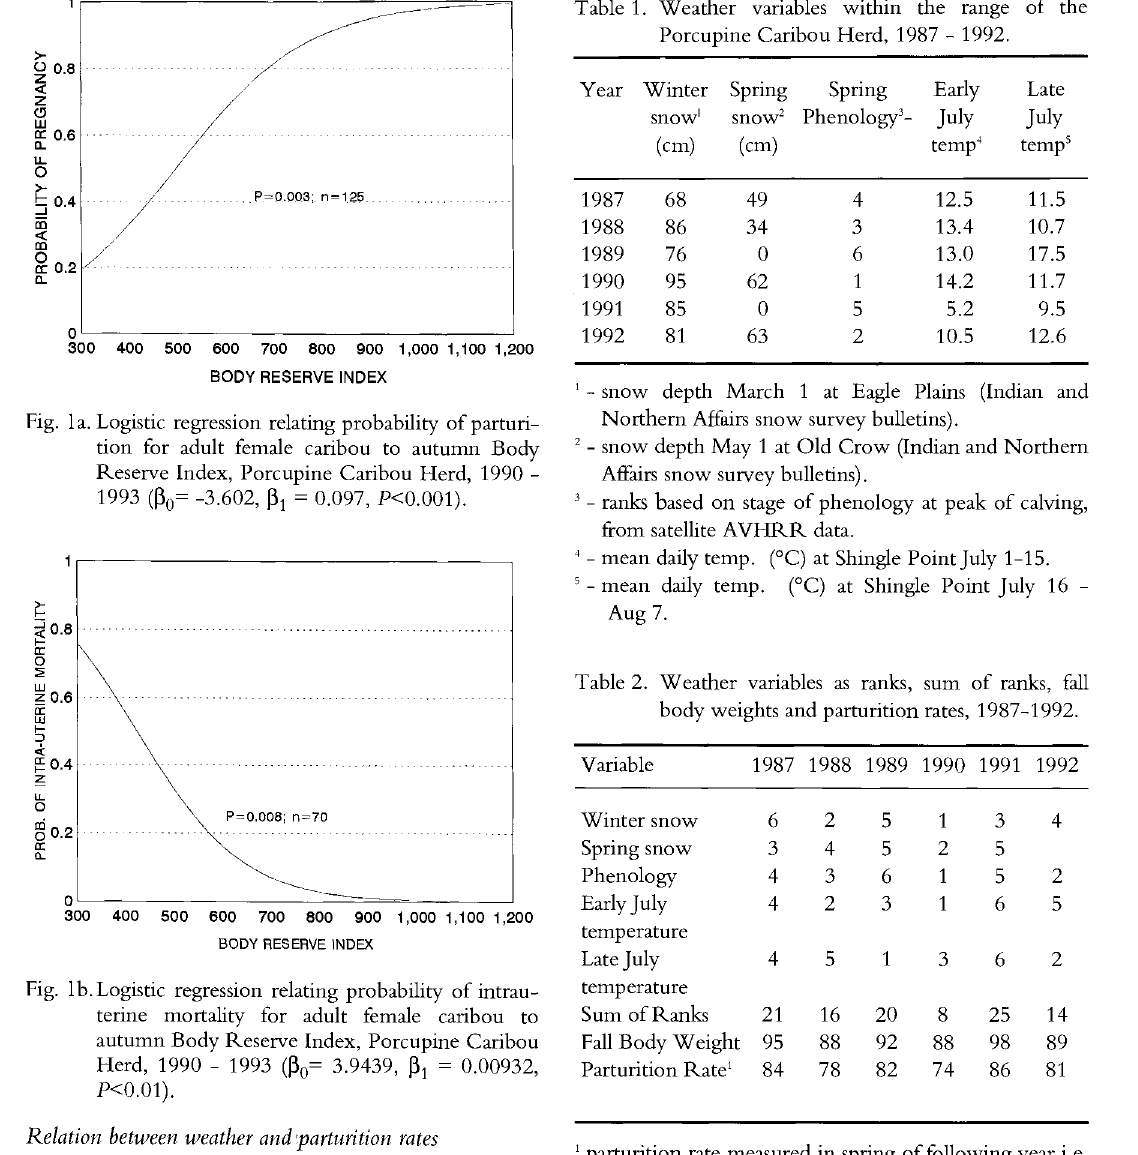
Table 1. Weather variables within the range of the Porcupine Caribou Herd, 1987 - 1992.